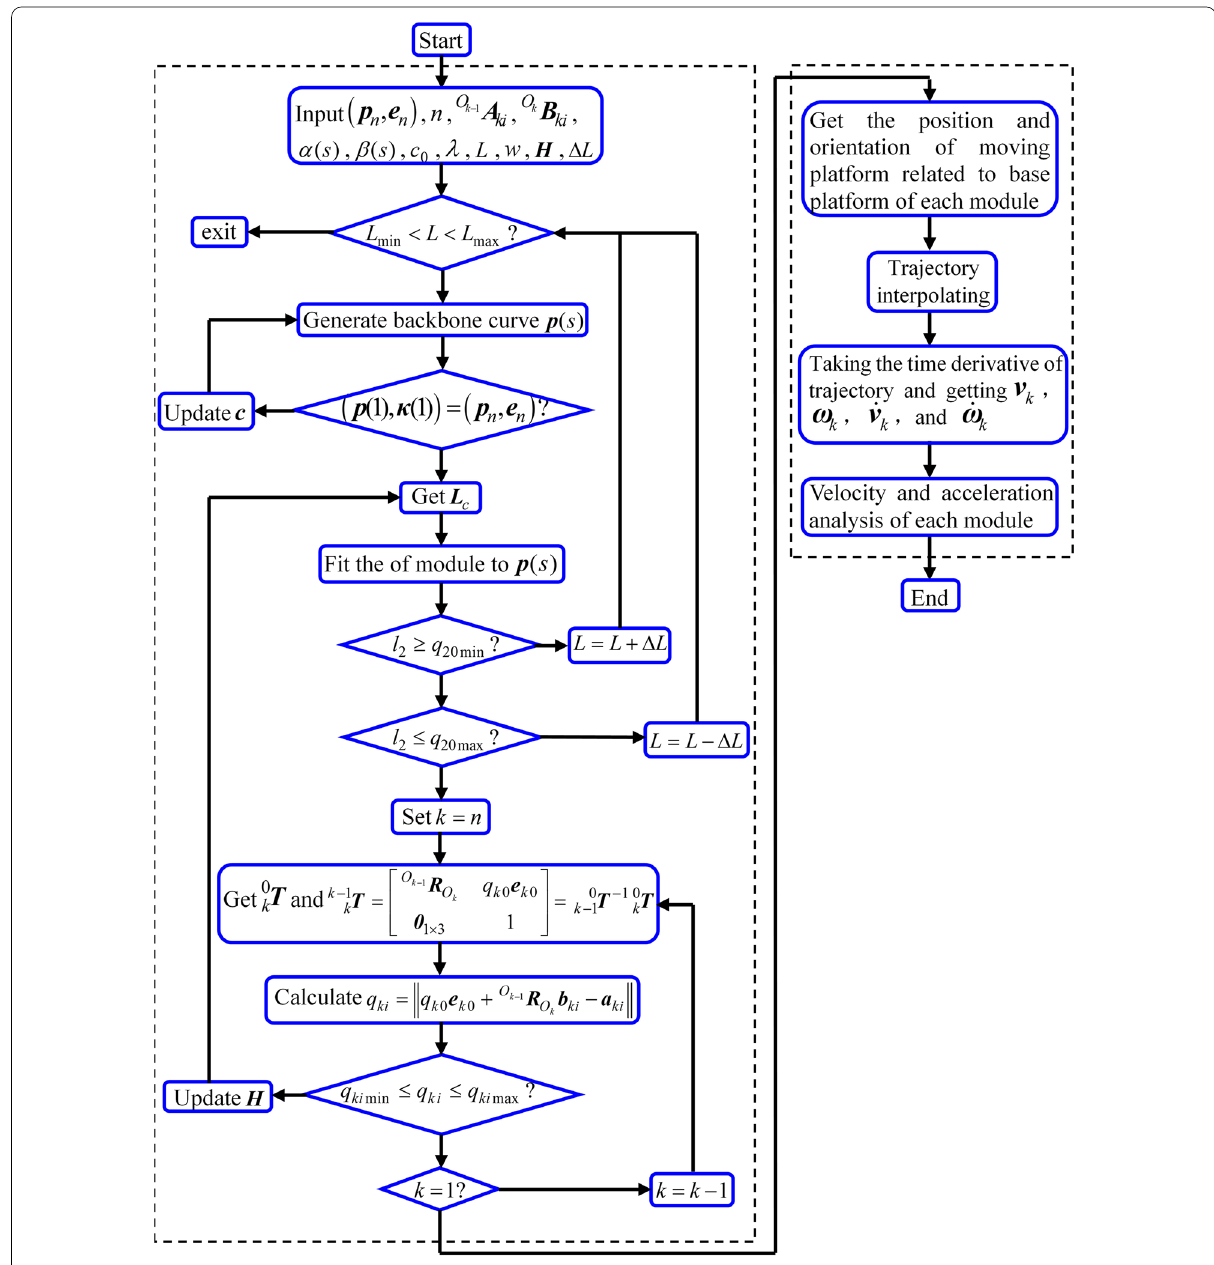
Figure 5 Kinematic algorithmic flow of the